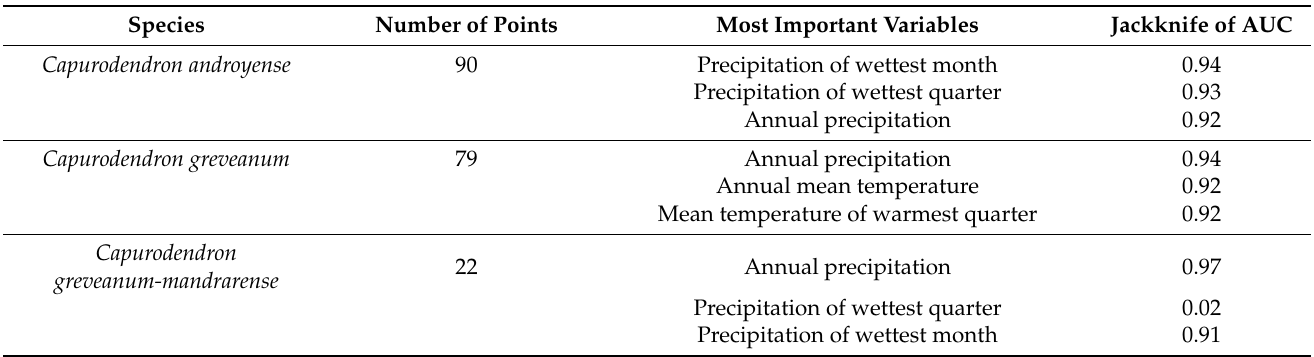
Table 6. The most important variables contributing to the potential distribution of each species. AUC = Area below the curve. Species Number of Points Most Important Variables Jackknife of